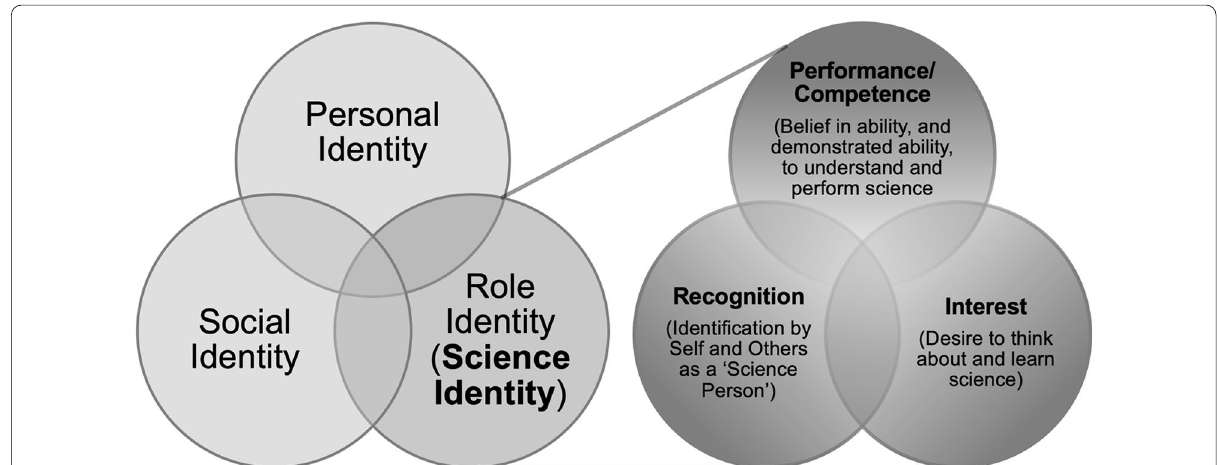
Fig. 1 Student Science Identity Model. Adapted from models originally developed by Carlone and Johnson (2007) and modified by Hazari et al.